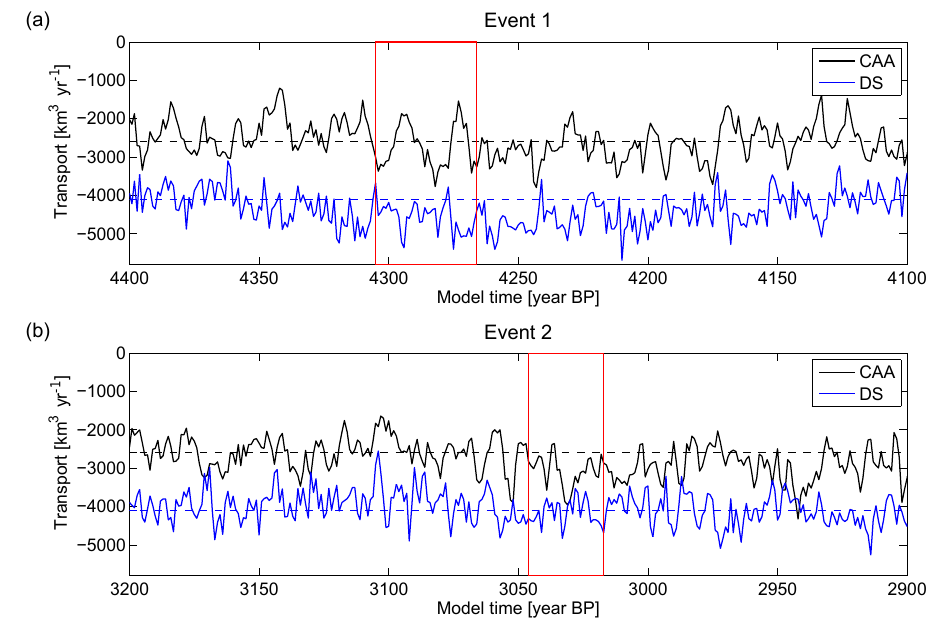
Figure 7. Freshwater flux through the Canadian Arctic Archipelago (CAA; black) and the Denmark Strait (DS; blue) with a reference salinity of 34.7PSU during (a) event 1 and (b) event 2. Negative values correspond to a southward transport. The red boxes indicate the time span of the events. The dashed lines represent the corresponding mean over the entire time span of the simulation.